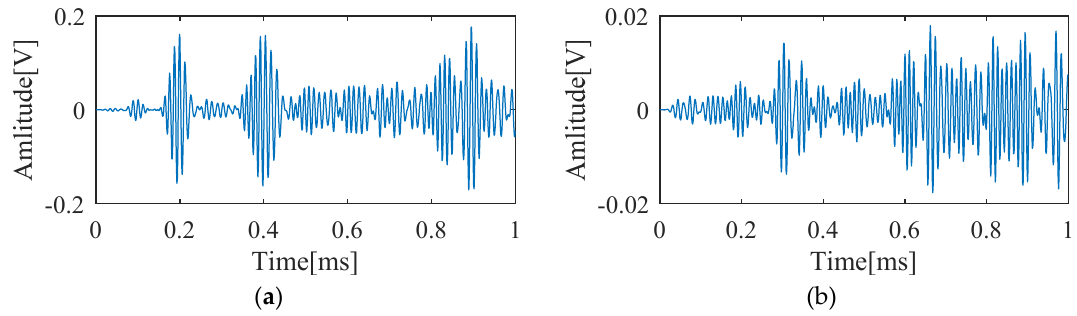
Figure 7. ( a ) The signal received by PZT 1 in the presence of defect #1; ( b ) the scattering signal obtained by subtracting the baseline from the signal shown in (a).